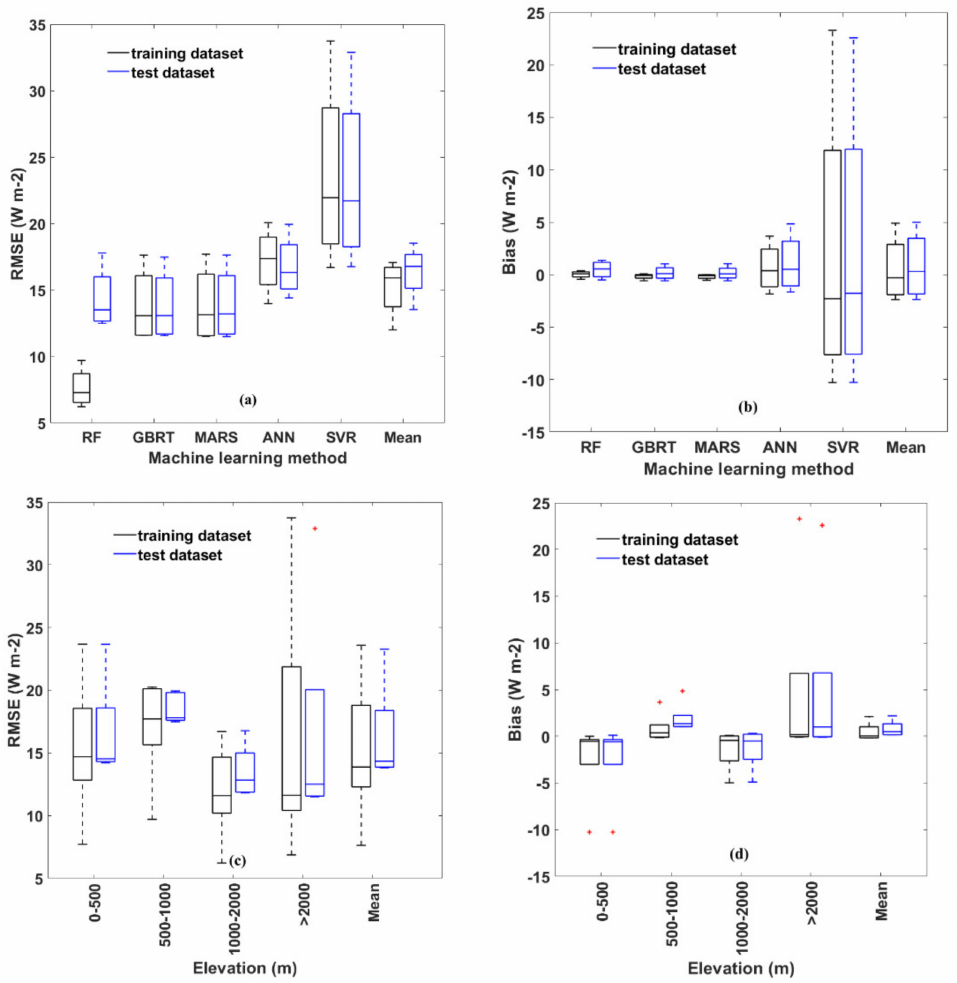
Figure 7. Box plots of the ( a ) RMSE and ( b ) bias of di ff erent elevation ranges for each method; the ( c ) RMSE and ( d ) bias of di ff erent machine learning methods at each elevation range. The middle line within the box represents the median value. The red asterisks represent the